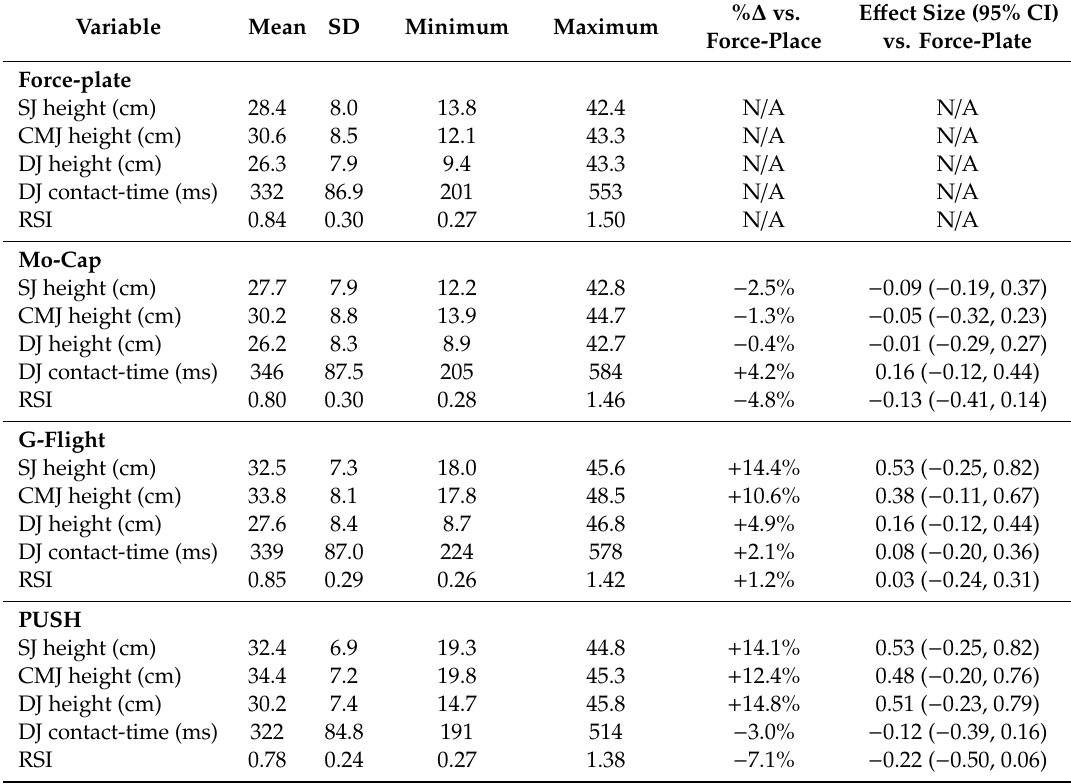
Table 1. Summary statistics for jump heights, contact-time, and reactive strength index across all devices, jumps, and